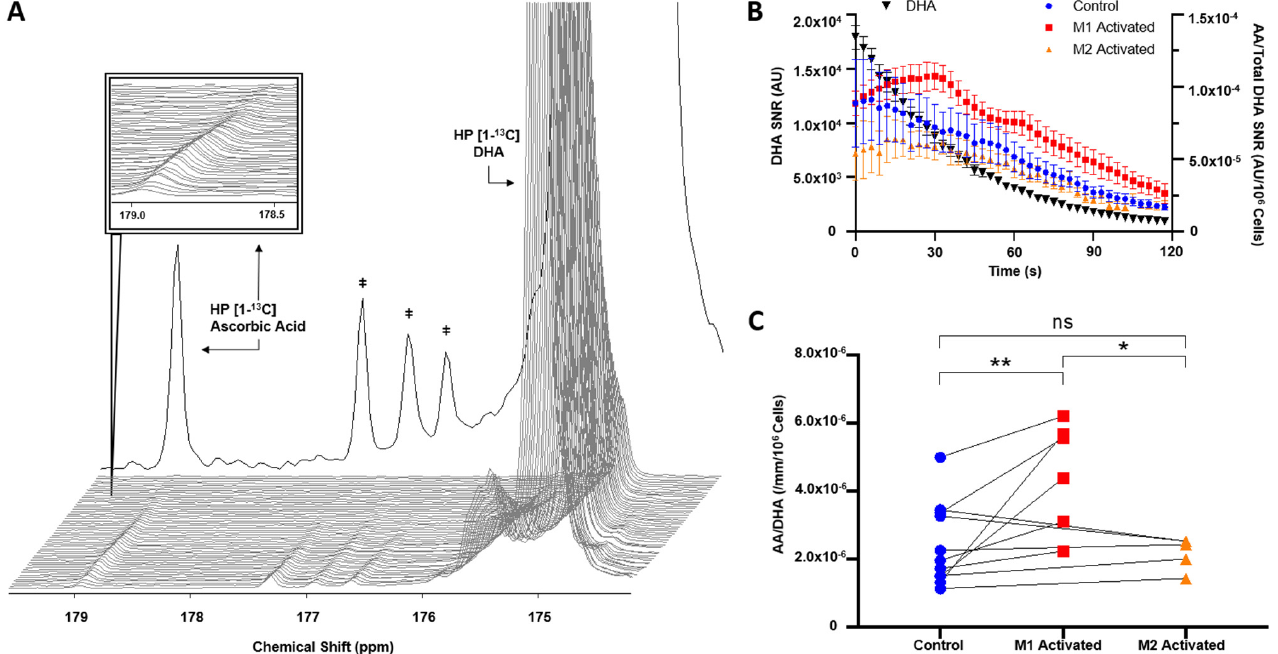
Figure 3. HP [1- 13 C]AA production is increased with M1 activation. ( A ) Dynamic spectra acquired at 1.47 Tesla post HP [1- 13 C]DHA injection into M1-activated J774a.1 macrophages, and sum spectra over 100 TRs in background (‡ contaminants). ( B ) Signal-to-noise ratio (SNR) of HP [1- 13 C]DHA decay from all injections (black, left y -axis) and HP [1- 13 C]AA production (right y -axis) in M1-activated (red), M2-activated (orange), and control cells (blue) over 120 s. ( C ) HP AA-to-DHA ratios measured in controls (blue) and their activation pairs (M1-activated red, M2-activated orange) ( NS : p = 0.9581, * p < 0.05, ** p < 0.01).